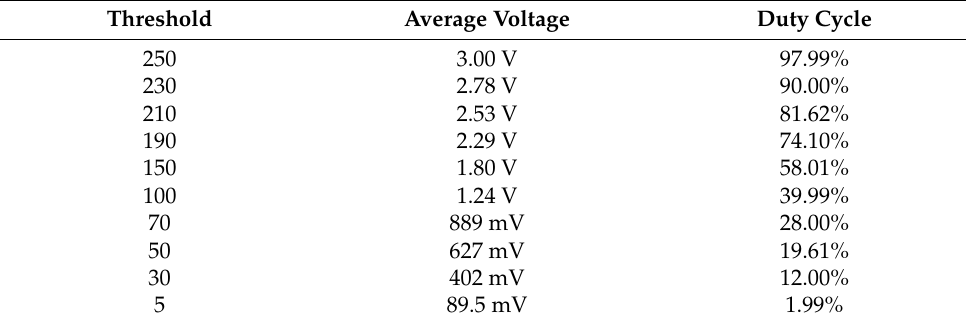
Figure 16. ( A ) EMG signal of the forearm muscle and ( B ) EMG signal of the genioglossus muscle. Table 1. Relationship between threshold and average impulse voltage